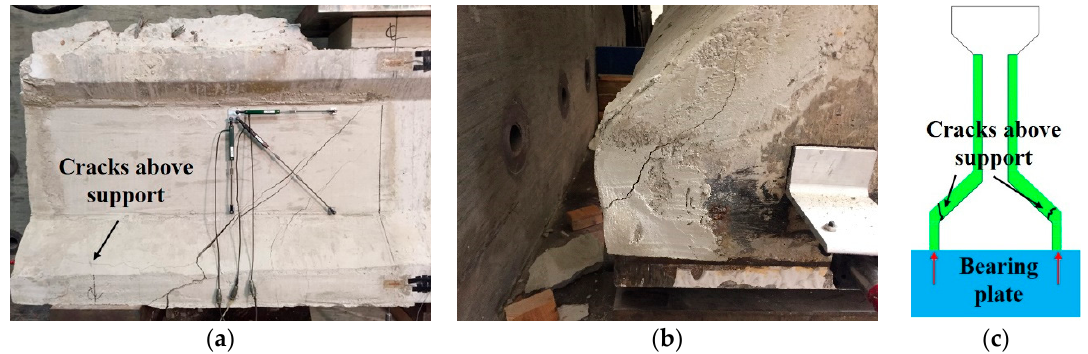
Figure 9. Failure mode of the mortar repaired specimen: ( a ) mortar after failure (1:27); ( b ) cracks above bearing plate (1:10) and ( c ) cracks caused by uneven force transfer.